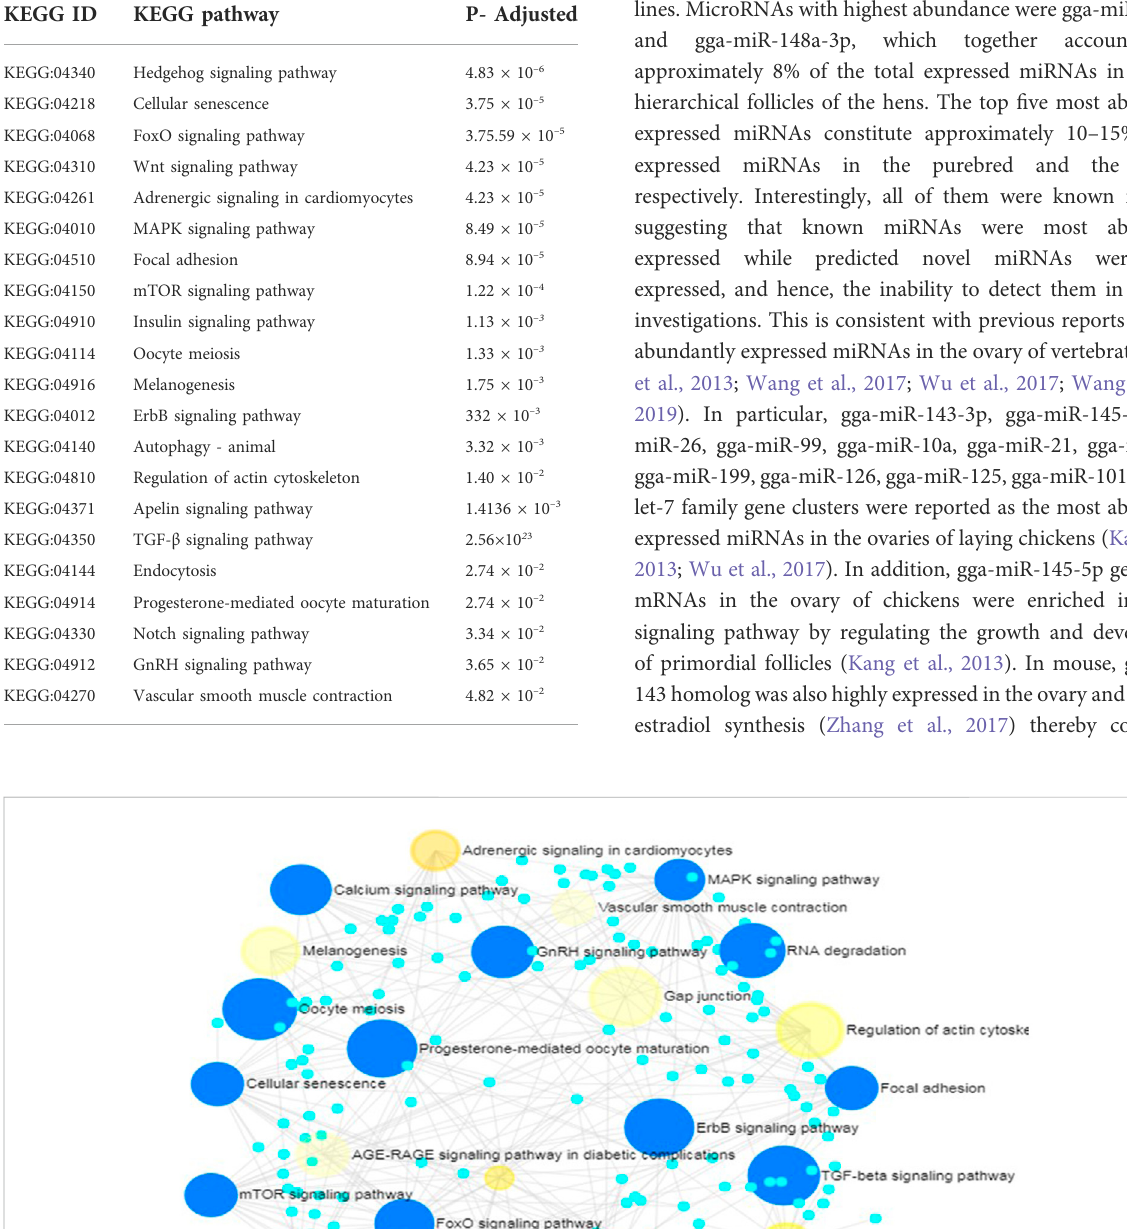
TABLE 3 Pathways enriched in the KEGG database for target genes of miRNAs with non-additive mode of expression. KEGG ID